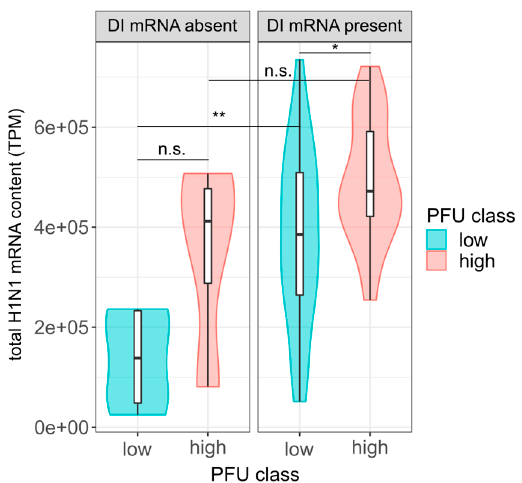
Figure 6. Influence of total viral mRNAs and DI mRNAs on the single-cell virus yield. At 12 hpi, single PR8-infected MDCK cells (MOI = 10) were investigated for virus yield by plaque assay (as shown in Figure 1), the total viral mRNA content and the presence of intracellular DI mRNAs on S1–S3 by scRNA-seq. Single cells were subdivided into DI mRNA positive and negative cells, according to the presence and absence of large insert sizes ( > 1000 bp), as shown in Figure 4A. Total viral mRNA content in transcripts per million (TPM) was calculated by removing read pairs with a large insert size. Colors indicate the lower and upper 22.86% of cells with respect to the virus yield (“low” and “high”, respectively), as shown in Figure 3B. Sample sizes from left to right ( n = 5, 4, 35, 27). *, p < 0.05; **, p < 0.005; n.s., p > 0.05, not significant (by the Wilcoxon rank sum test). The pooled data of multiple independent experiments are depicted ( n = 3).